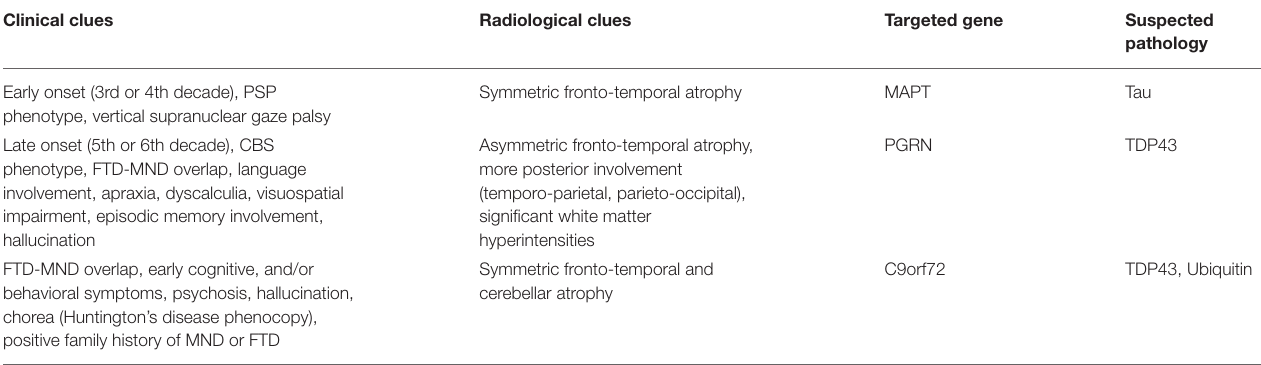
TABLE 5 | Clinical and radiological clues for familial FTD with Parkinsonism. Clinical clues Radiological clues Targeted gene Suspected